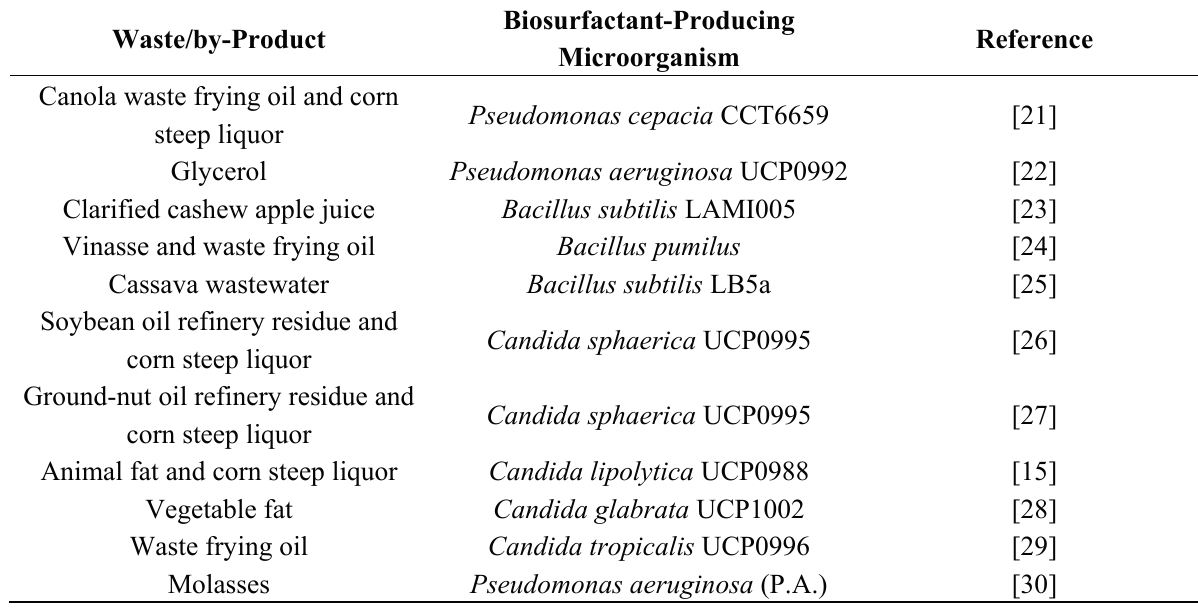
Table 2. Waste and byproducts used for biosurfactant production and respective producing